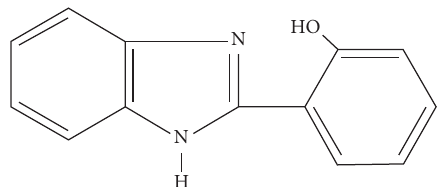
Figure 1: Chemical structure of 2-(2-hydroxyphenyl)-1H-